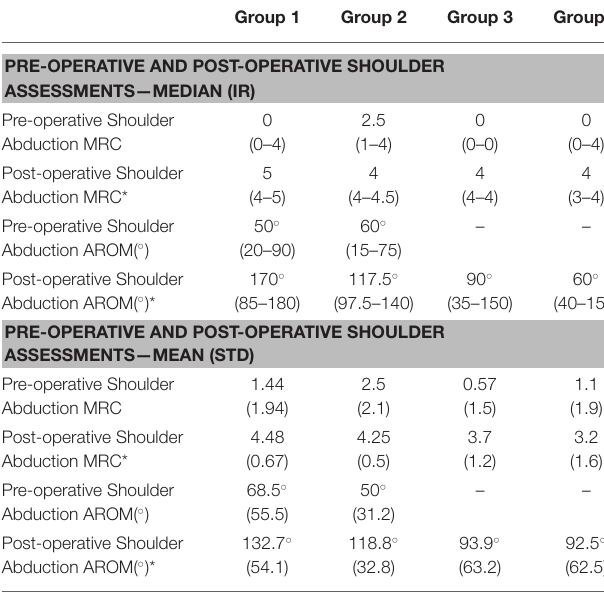
TABLE 3 | Patient and injury demographics. TABLE 4 | Pre- and post-operative shoulder abduction